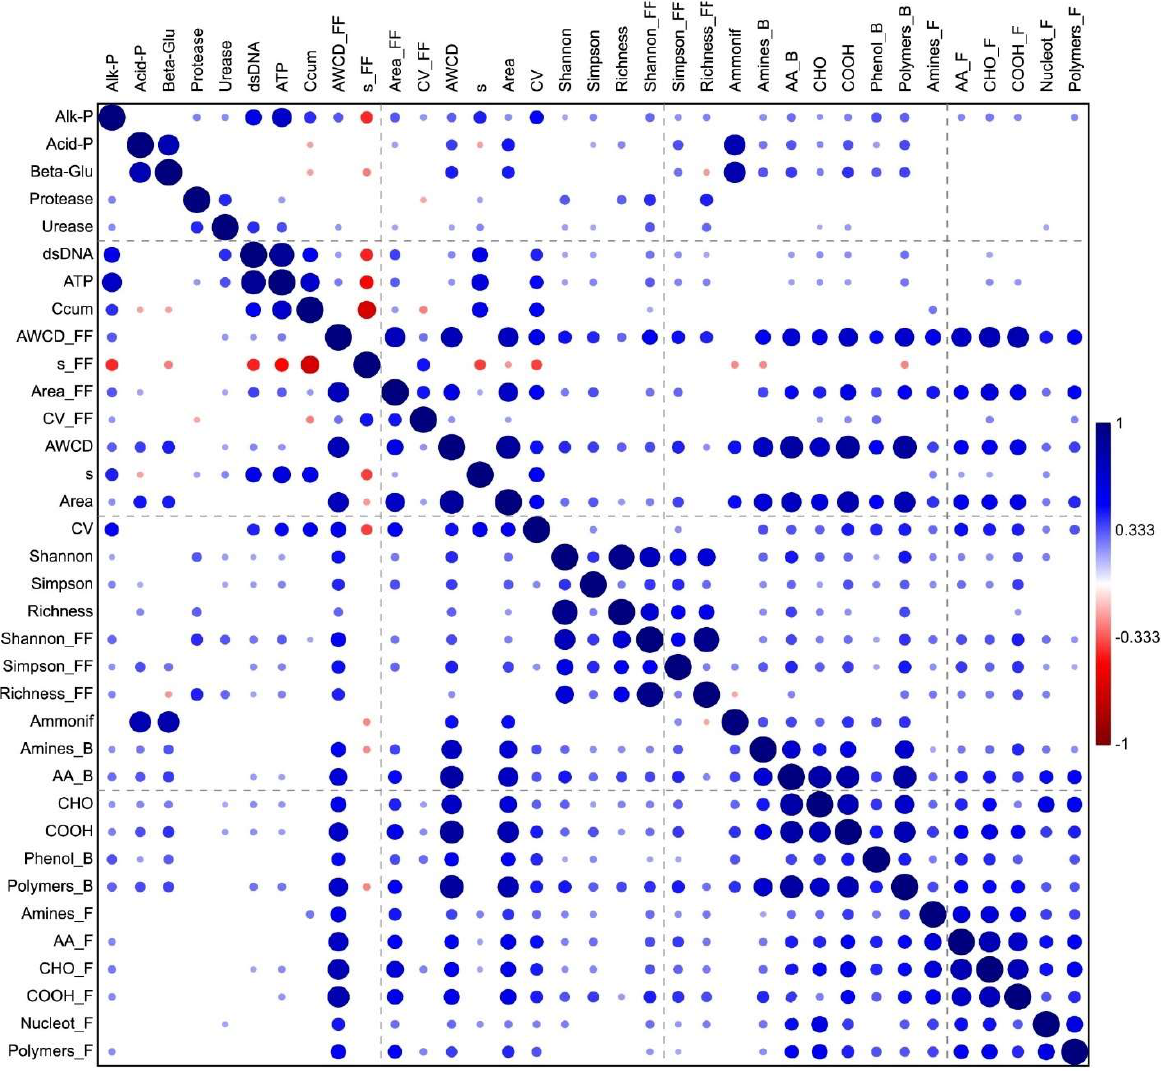
Figure 5. Pairwise Pearson’s correlation analysis. The two specular triangles display the Pearson’s correlation coefficient (r) between each of the two soil characteristics. Blue and red colors indicate positive and negative correlations, respectively. The color density and the square size reflect the scale of the correlation. Color density and circle size demonstrate the significance level, and p- values above 0.05 were regarded as insignificant and labeled in white color. Variables indicated with B or FF are referred to bacteria or fungi, respectively. Abbreviations: Alk-P (alkaline phosphatase), Acid-P (acid phosphatase), Beta-Glu (beta-glucosidase), dsDNA (double-strand DNA), Ccum (cumula- tive respiration), s_ (catabolic kinetics), Area (area of the CLPP curve), CV (catabolic versatility), Ammonif (ammonification), AA (amino acids), CHO (carbohydrates), COOH (carboxylic acids), Phenol (phenolic compounds), Nucleot (nucleotides). The outcomes of the PCA showed a clear separation among Val (red), Rom (blue) and Vic (black) soils along PC1 and PC2, which explained, respectively, 26.9% and 25.7% of variance (Figure 6). The results also indicated contrasting contributions to PC1 by β- glucosidase, acid phosphatase and ammonification (negative loadings) and alkaline phos- phatase, urease and most of the biochemical properties (positive loadings). The contribu- tion of microbial catabolic activity and diversity appeared to be less relevant. Interest- ingly, bacterial catabolic efficiency (Area_B) and taxonomical richness (Rich_B) were closely associated with β-glucosidase, acid phosphatase and ammonification and posi- tively related to Val soils, whereas fungal catabolic potential (AWCD_FF) and taxonomic richness (Rich_F) were associated with urease, alkaline phosphatase (AlP) and soil respi- ration (Ccum), as well as dsDNA and ATP, and were strongly related to Vic soils.